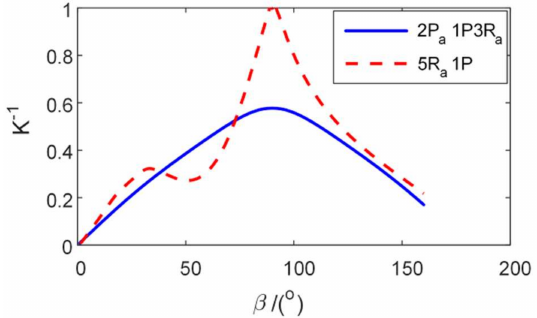
Figure 15. Comparison between the reciprocal of the condition number and the curve of the uplift angle.